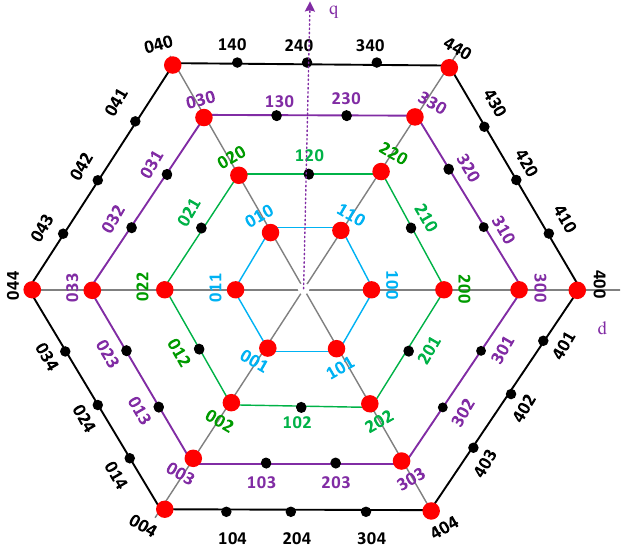
Figure 6. Generalized switching states for generating different number of levels in the pole voltage. Reprint with permission [4261051118814]; 2018, IEEE.